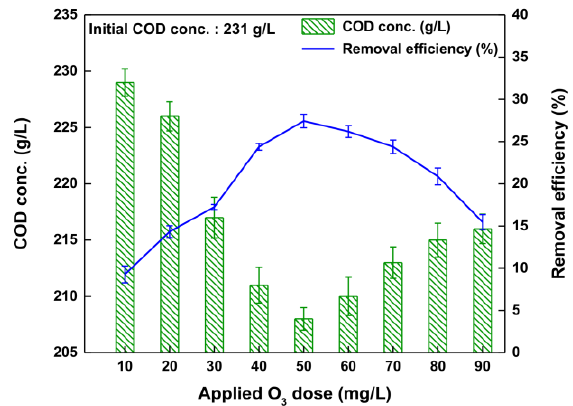
Figure 7. Removal efficiency of COD with various applied O 3 doses for O 3 oxidation.